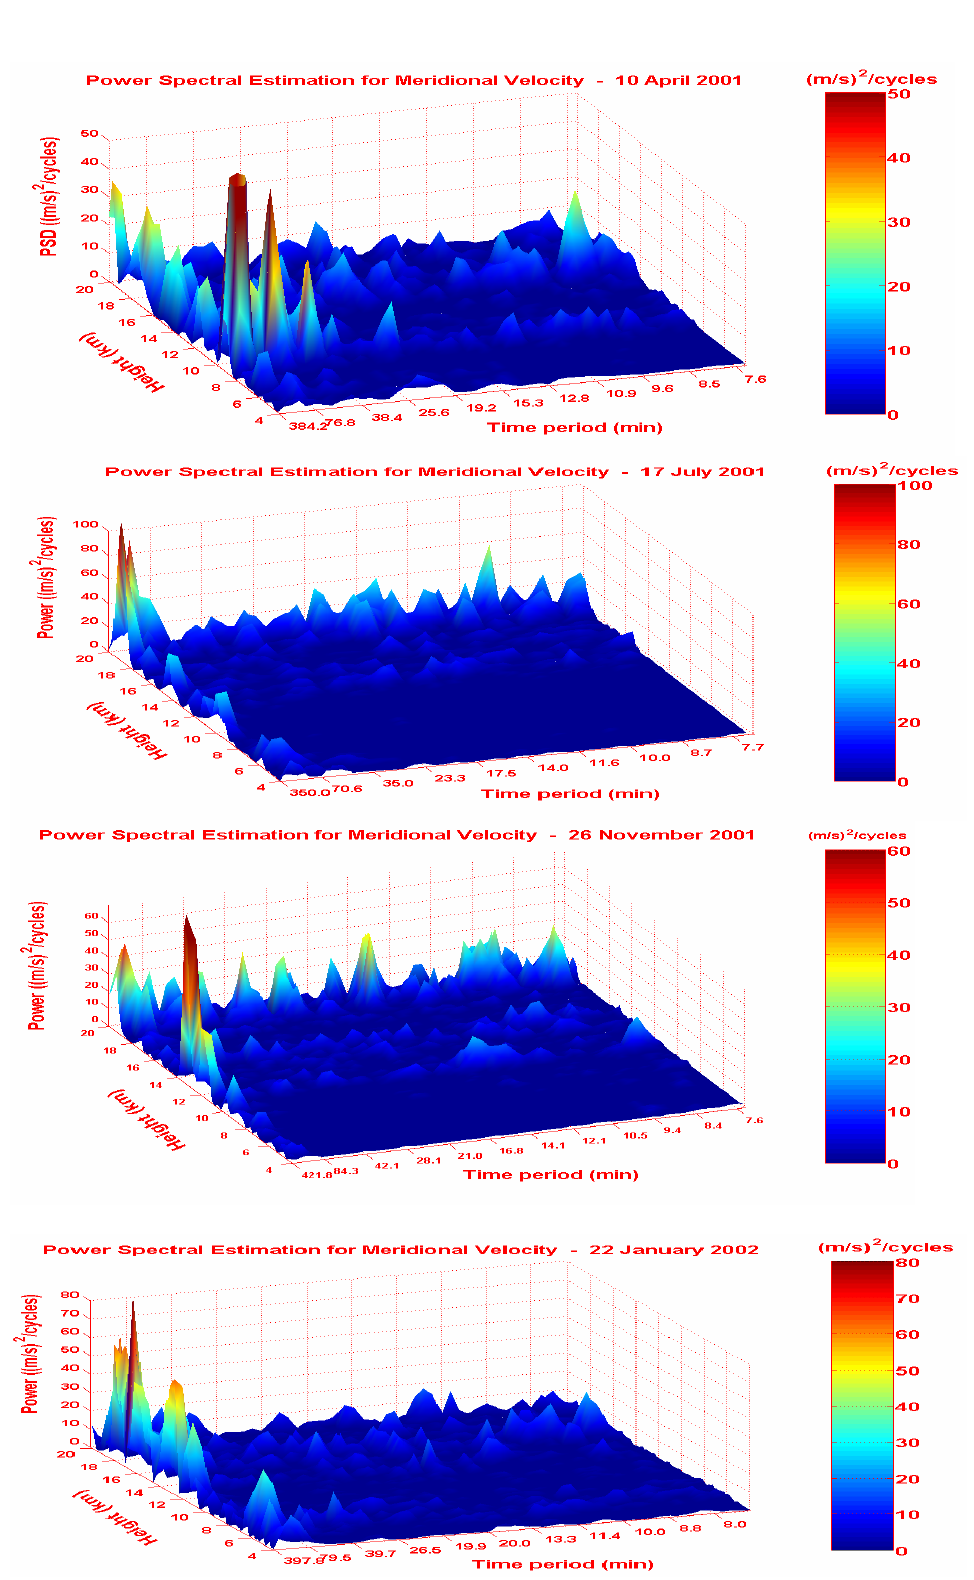
Fig. 9. Fig. 9. Same as Fig. 8, but for the meridional velocity during the same